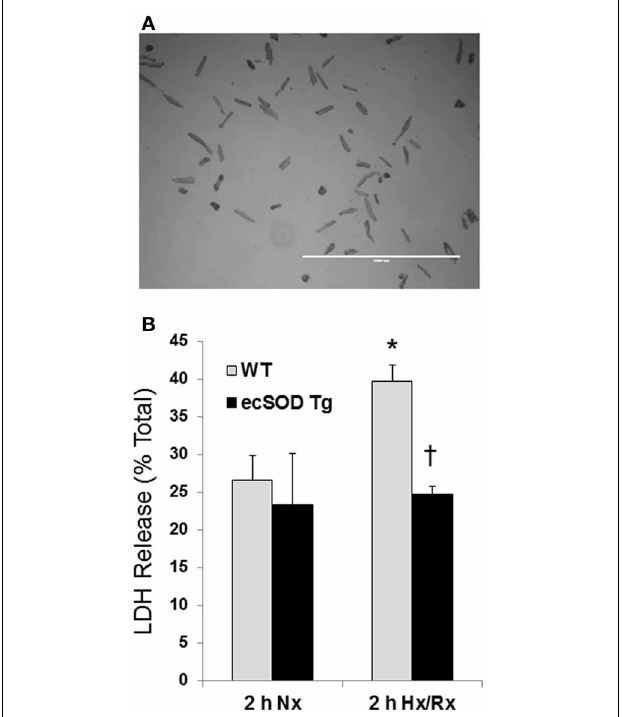
FIGURE 1 | ecSOD Tg cardiac myocytes are resistant to hypoxia/reoxygenation injury. Cardiac myocytes from WT and ecSOD Tg mice were isolated, cultured, and incubated under hypoxic conditions, 1% O 2 , 94% N 2 , and 5% CO 2 in hypoxic media for 30min followed by 120min reoxygenation ( Upper panel , scale bar = 1mm). Myocyte viability was assessed by measuring LDH activity in supernatants collected from cells under normoxia and after reoxygenation ( Lower panel ). Values are the mean ± SEM of 3 experiments performed in duplicate. ∗ p < 0 . 05 vs. Nx (WT or Tg), † p < 0 . 05 vs. WT 2h